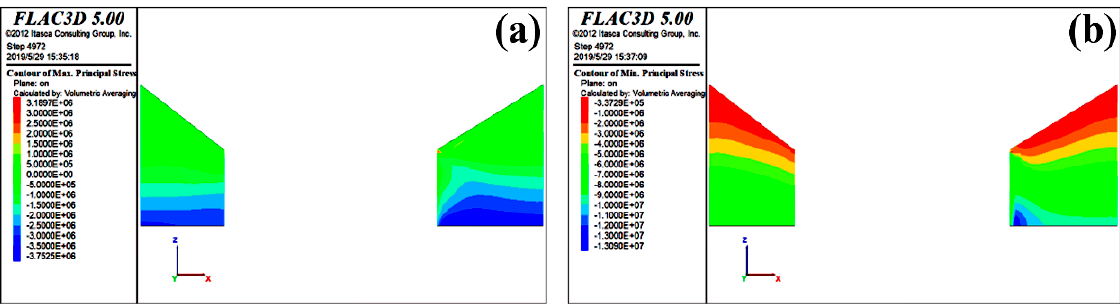
Figure 11. Slope: maximum ( a ) and minimum ( b ) principal stress distributions.